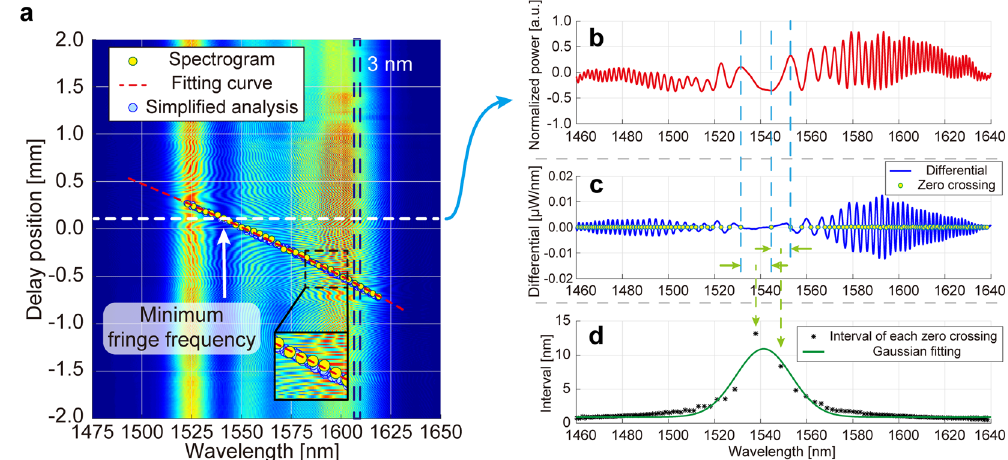
Figure 3. Results of the position measurement. ( a ) False colour plot of spectral interference fringes obtained by changing delay positions. A series of data points corresponding to minimum fringe frequencies (MFFs) are plotted. The 33 yellow circles labelled ‘Spectrogram’ were obtained via FFT, while the blue circles labelled ‘Simplified analysis’ were obtained via the differentiation of the spectrum ( b – d ). Details can be found in Methods